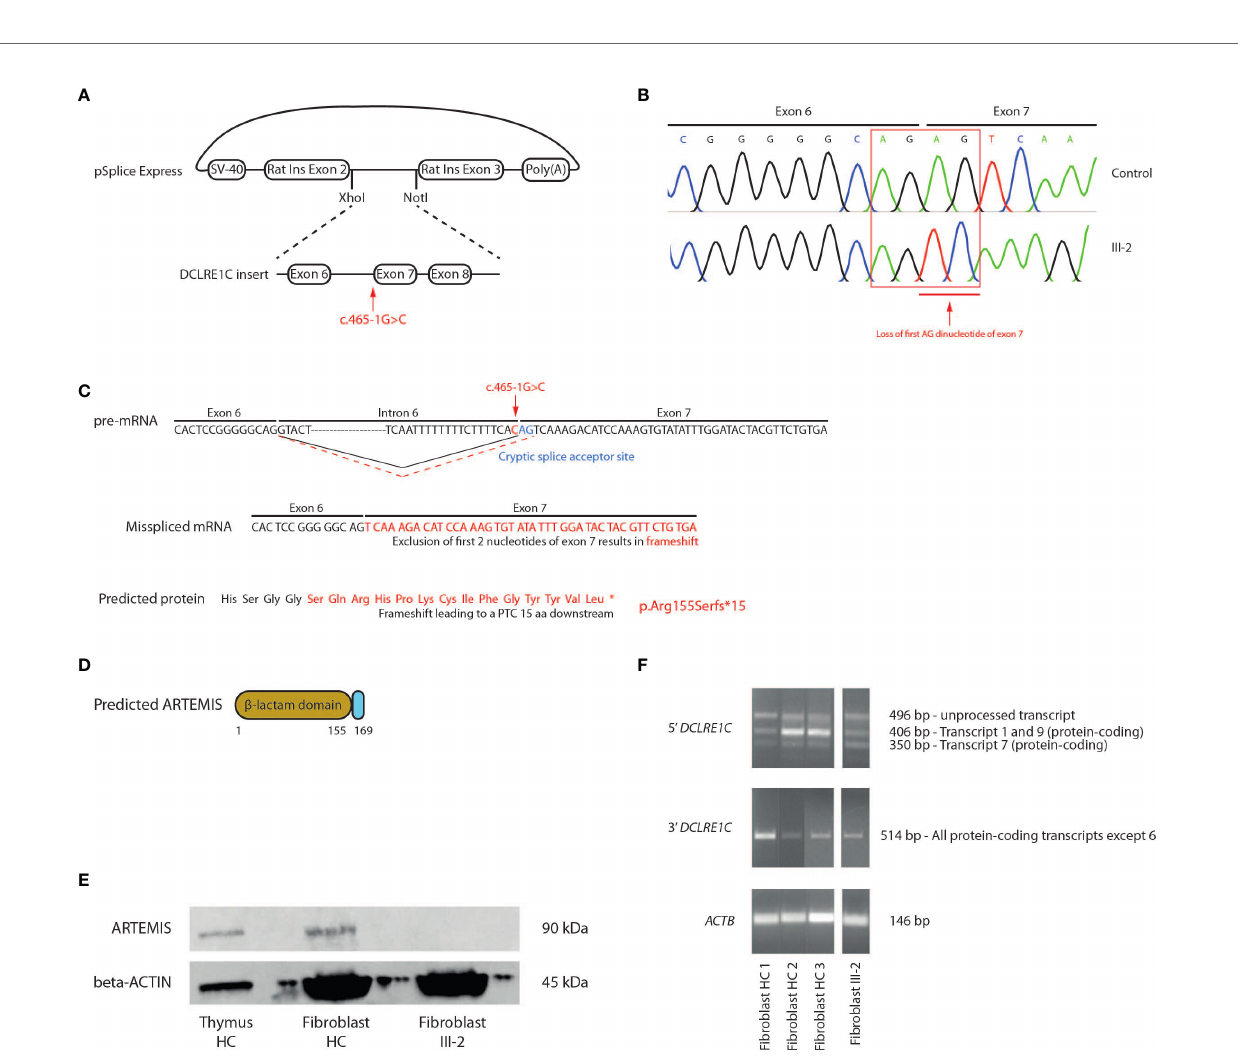
FIGURE 3 | Molecular study of the DCLRE1C gene and ARTEMIS protein reveals an alternative splicing mechanism leading to a frameshift mutation and a PTC. (A) Schematic representation of the generation of the pSplice Express vector containing the patient DCLRE1C minigene with the c.465-1G>C variant. The minigene containing exons 6, 7, 8 and corresponding introns is cloned in between the two rat insulin exons by XhoI and NotI compatible overhangs. The location of the variant is indicated by the red arrow. (B) cDNA Sanger sequencing of the minigenes of both control and patient, expressed by host HEK cells. Sanger electropherograms of both minigenes are depicted and the loss of the AG dinucleotide at the start of exon 7 is indicated by the red arrow. (C) Schematic representation of the pre-mRNA, mRNA and ARTEMIS protein containing the altered sequence resulting from the alternative splicing. On the pre-mRNA level, the new cryptic splice acceptor site in exon 7 is depicted in blue. The canonical splicing pattern is shown by a solid black line whereas the alternative splicing mechanism is indicated by a dashed red line. The location of the c.465-1G>C variant is depicted in red. On the mRNA and protein level, the altered sequence that results in a frameshift and a PTC is shown in red. The PTC is depicted as an asterisk on the truncated ARTEMIS protein (*). (D) Schematic representation of the truncated ARTEMIS protein, as predicted by the alternative splicing event. (E) Western blot analysis for the ARTEMIS protein (upper panel) and for beta-ACTIN (lower panel) on total thymus, HC fi broblast and patient fi broblast lysates (n=3). HC, Healthy Control. (F) RT-PCR of DCLRE1C cDNA of 3 independent fi broblast controls and patient fi broblasts. The upper panel shows the 5 ’ RT-PCR of DCLRE1C cDNA, with 3 bands each representing a different DCLRE1C transcript corresponding to the transcripts shown in Supplemental Figure 2 . The middle panel shows the 3 ’ RT-PCR of DCLRE1C cDNA. The lower panel depicts the RT-PCR of ACTB as a positive control. HC, Healthy Control; PTC, Premature Termination